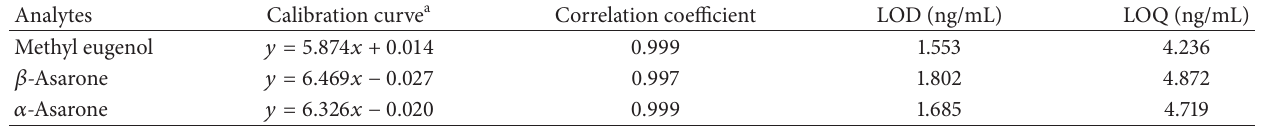
Table 1: Analytical parameters for GC-MS of plasma analytes assayed by the present